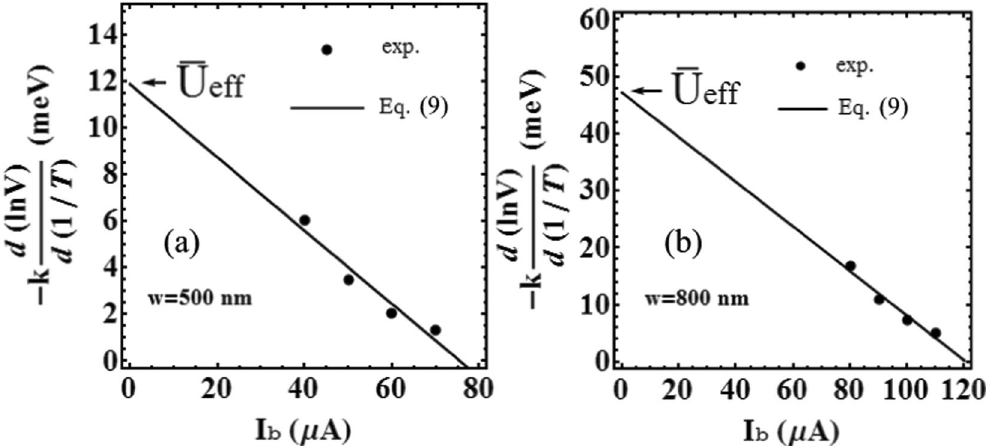
Figure 5. Experimental relation between d V d T (ln )/ (1/ ) and the bias current I b , for  T T and sample B, ( b ). The value of d V d T (ln )/ (1/ ) is obtained from the slope of the − V T log( ) 1/ relation shown in Fig. 4(a,b), respectively. We consider the lowest four temperatures and the corresponding four experimental values of d V d T (ln )/ (1/ ) . The solid line is equation (9) with I c (0) = 76 μ A, U (0) = 11.9 meV for sample A,